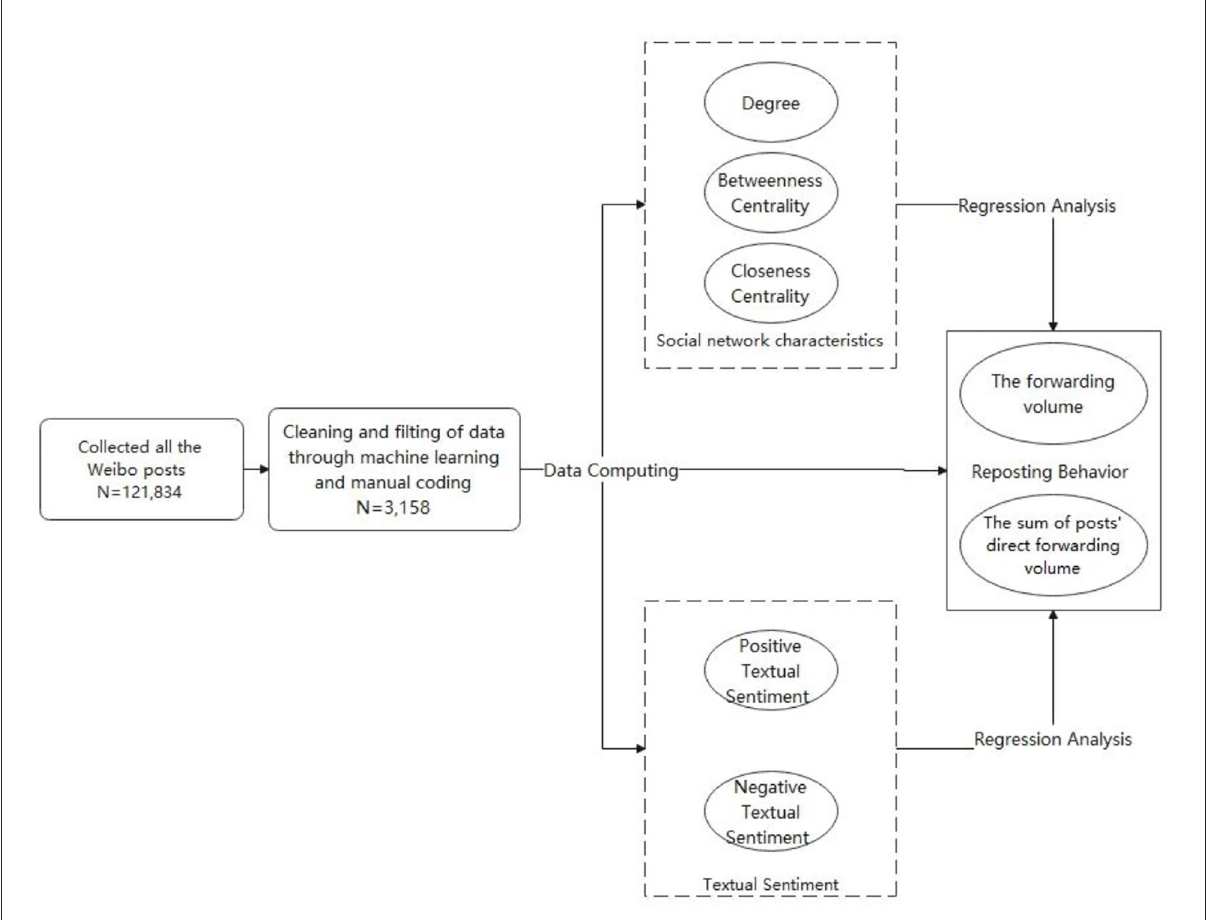
FIGURE1 Research design